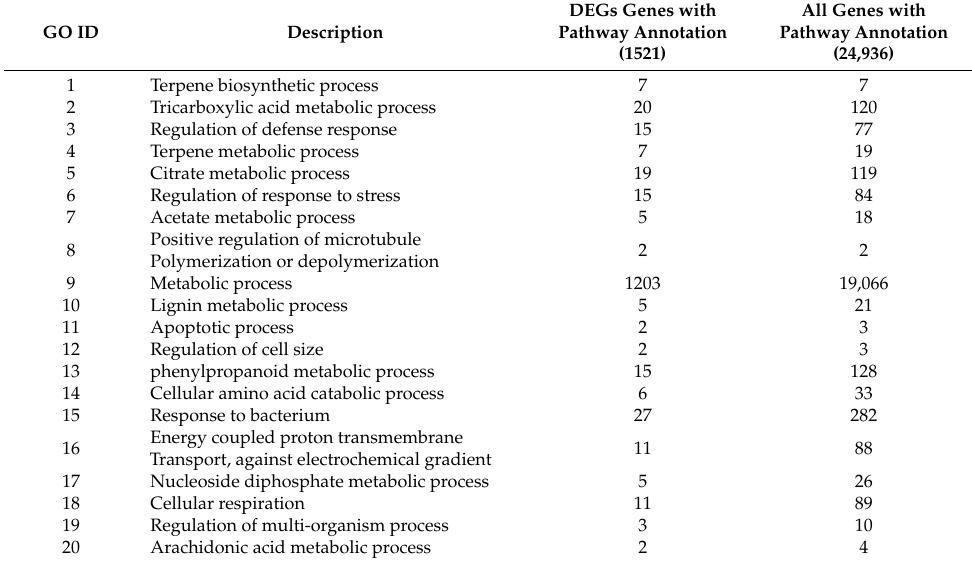
Table 2. The enriched differential progress top 20.